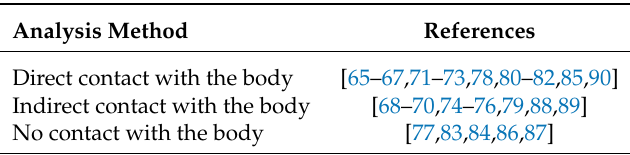
Table 10. Analysis method.